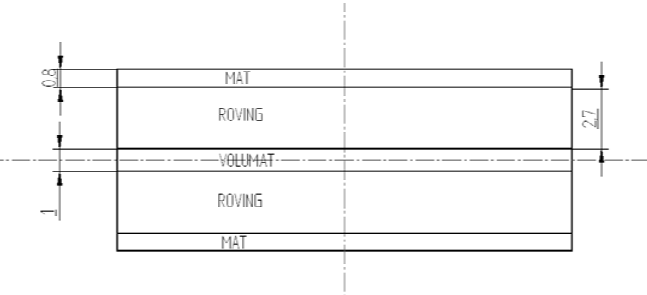
Figure 3: Layer disposition in a generic section of the samples.